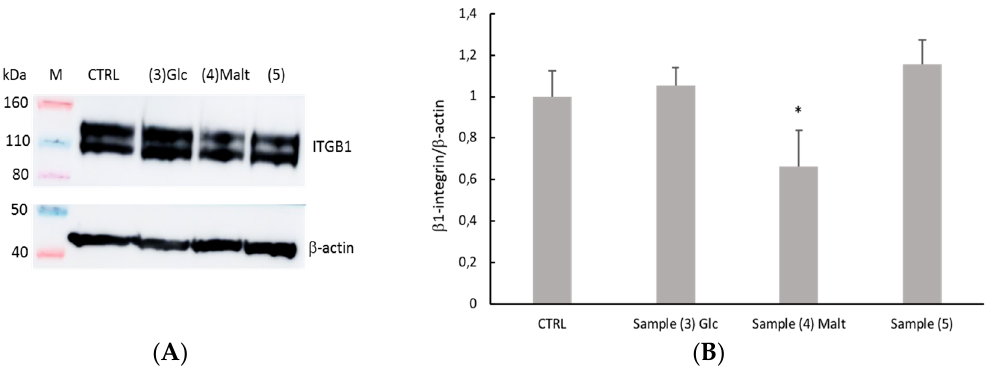
Figure 6. Expression of ITGB1 in differentiated SHSY5Y cells after growing on different collagen films. SHSY5Y cells were cultured on collagen samples for 7 days and subjected to total protein extraction. The total protein extract was analyzed by SDS-PAGE/WB and probed by anti-ITGB1. ( A ) WB of the total cell protein extracts analyzed for b-actin and ITGB. ( B ) The intensity of chemiluminescent bands was semi-quantitatively estimated with Amersham Imager 600 and expressed as the ratio between the intensity of the spot of interest (ITGB) and the intensity of β -actin bands. Data are mean ± SD and compared by Student’s t-test (* p < 0.05).